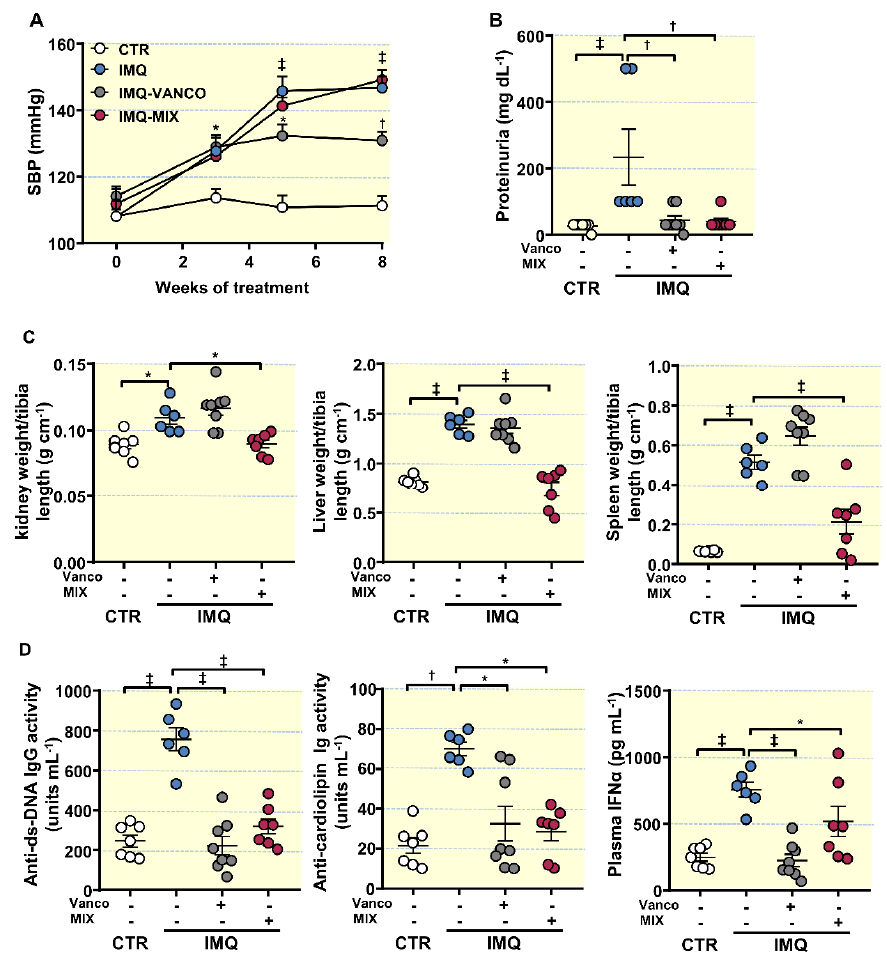
Figure 1. Effects of microbiota modification through population depletion with antibiotics on blood pressure, proteinuria, morphology, and disease activity in the imiquimod (IMQ) group. ( A ) Systolic blood pressure (SBP) assessed with tail-cuff plethysmography, ( B ) proteinuria, ( C ) organ hypertrophy levels, ( D ) circulating double-stranded DNA (anti-ds-DNA) and anti-cardiolipin autoantibodies, and interferon (IFN) α levels in control (CTR), IMQ and IMQ-groups treated with Vancomycin (VANCO) or a cocktail of antibiotics (MIX). The data is represented as means ± SEM. The evolution of tail SBP was analysed by two-way ANOVA with the Tukey’s multiple comparison test. The rest of the variables were tested with one-way ANOVA and Tukey post hoc test (morphological variables, and plasma anti-ds-DNA), or Kruskal–Wallis with Dunn’s multiple comparison (proteinuria, anti-cardiolipin, plasma IFN α ). * p < 0.05, † p < 0.01, ‡ p < 0.001 in comparison with CTR; * p < 0.05, † p < 0.01, ‡ p < 0.001 in comparison with IMQ.